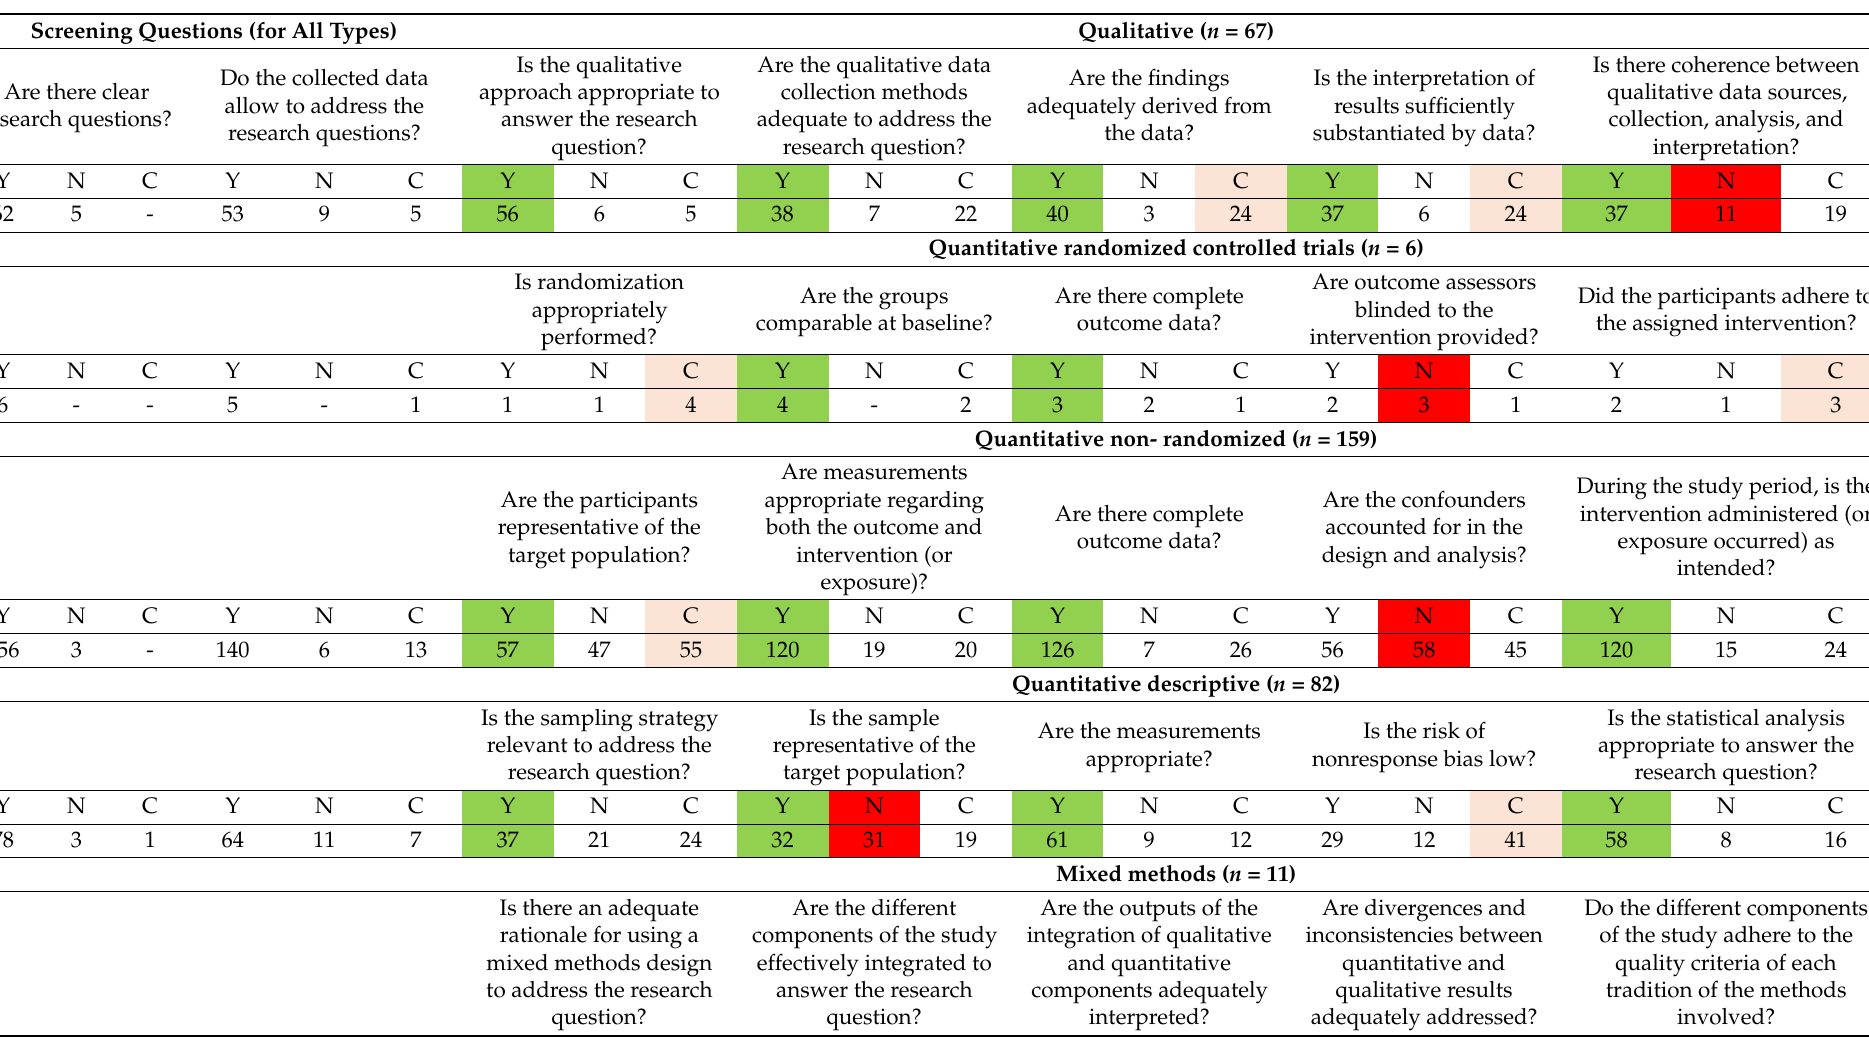
Table 3. Critical appraisal of included sources of evidence through the Mixed Methods Appraisal Tool (MMAT), n = 325. Screening Questions (for All